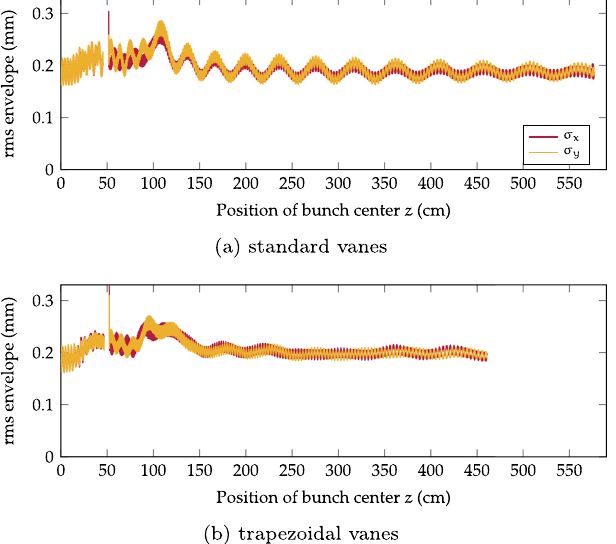
FIG. 15. Rms beam envelopes computed from the FEM field map for the standard (a) and trapezoidal design (b). (The discontinuity at z ¼ 50 cm is a nonphysical artifact originating in the removal of macroparticles from the tracking simulation, that are not captured in the rf bucket.)